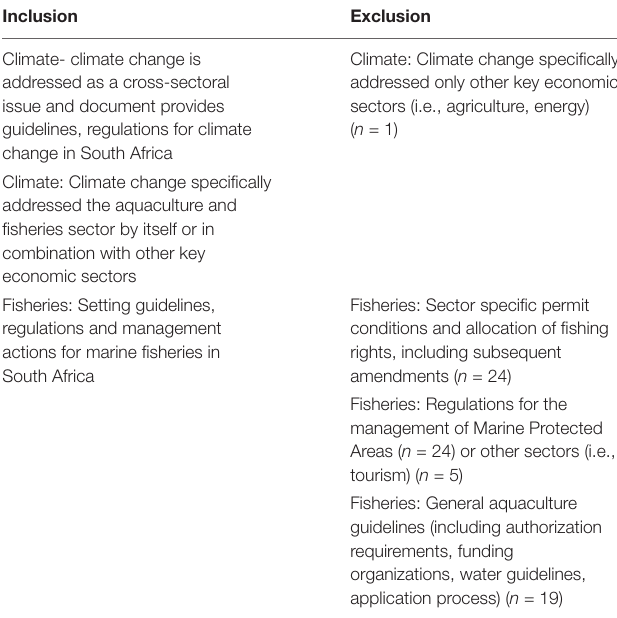
TABLE 4 | Inclusion and exclusion criteria used to select document for analysis.